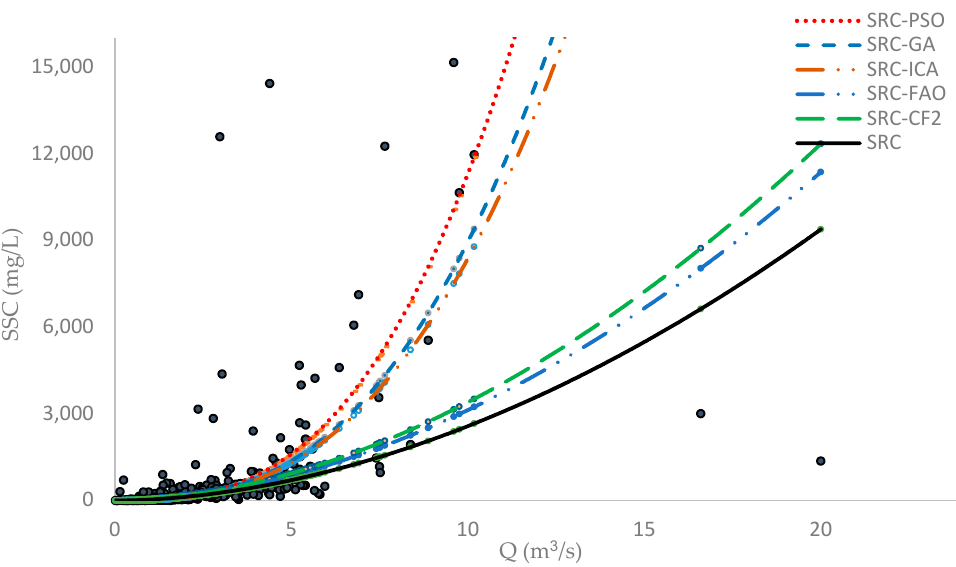
Figure 3. Fitness of various SRC models to the training phase.